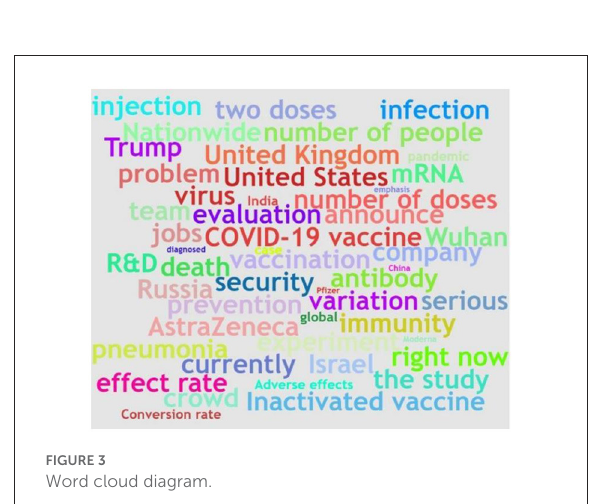
FIGURE3 Word cloud